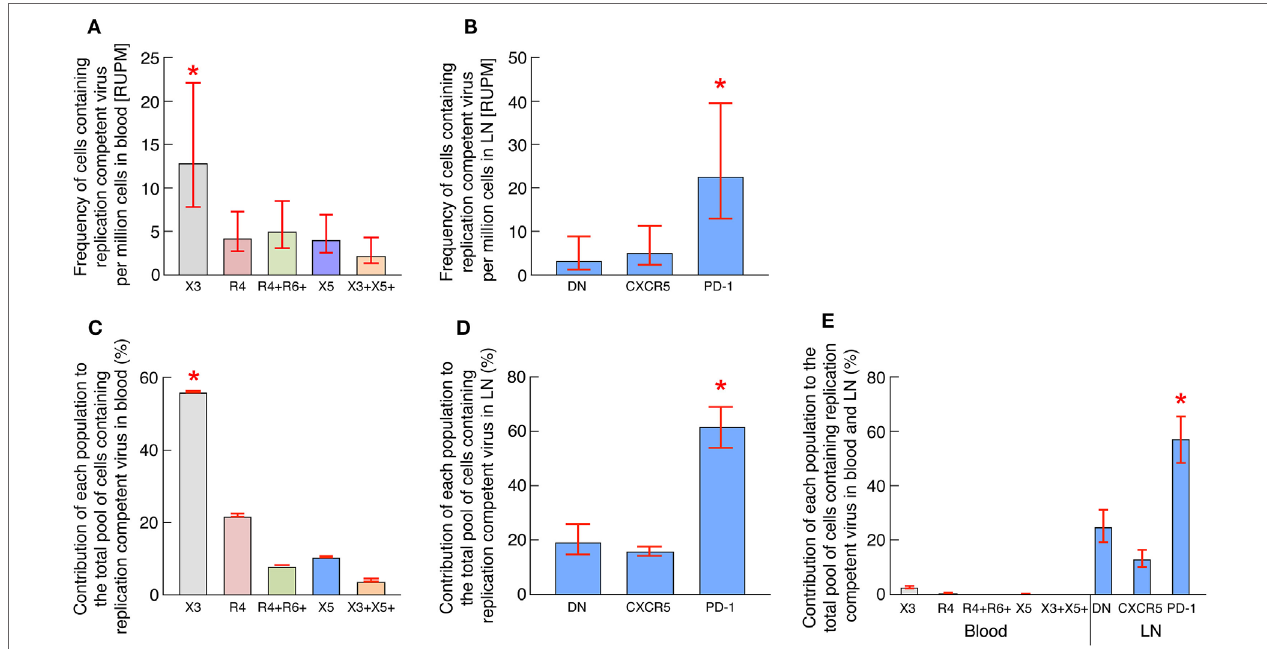
FigUre 3 | Blood CXCR3-expressing CD4 T cells of long-term-treated aviremic HIV-1-infected individuals are enriched in cells containing replication competent virus. (a) Estimated RNA-unit per million (RUPM) frequencies in chemokine receptor expressing blood memory CD4 T-cell populations ( N = 13). (B) Estimated RUPM frequencies in CXCR5 and/or PD-1 expressing lymph node (LN) memory CD4 T-cell populations ( N = 11). (c) Estimated contribution of blood memory CD4 T-cell populations to the pool of cells containing replication competent virus in blood ( N = 13). (D) Estimated contribution of LN memory CD4 T-cell populations to the pool of cells containing replication competent virus in LN compartment ( N = 11). (e) Estimated contribution of blood and LN memory CD4 T-cell populations of matched individuals to the total pool of cells containing replication competent virus in blood and LN compartments ( N = 6). Contribution of memory CD4 T-cell populations to the pool of cells containing replication competent virus was calculated as previously described (17). Histograms correspond to estimated mean (a–e) and red bars correspond to the lower and upper confidence interval at 0.95 (a–e) . “X3” corresponds to blood CXCR3-expressing CD4 T cells; “R4” corresponds to blood CCR4-expressing CD4 T cells; R4 + R6 + corresponds to blood CCR4 + CCR6 + CD4 T cells; “X5” corresponds to blood CXCR5-expressing CD4 T cells; And X3 + X5 + corresponds to blood CXCR3 + CXCR5 + CD4 T cells. “LN” corresponds to lymph node. Red stars indicate statistical significance ( P < 0.05). Statistical significance ( P -values) was either obtained using Extreme Limiting Dilution analysis (http://bioinf.wehi.edu.au/software/elda/) (a,B) , by pairwise comparisons of proportion with FDR correction (multiple tests) (c,e) or by Fisher’s exact test for pairwise comparisons (D)